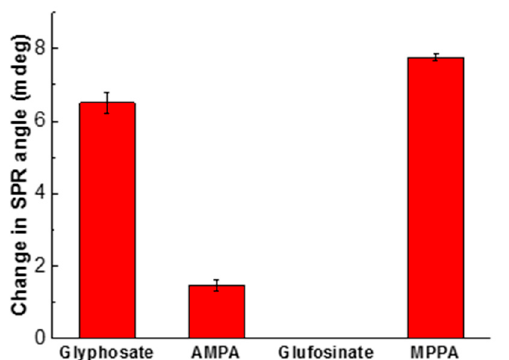
Figure 13. Sorption behavior of glyphosate, AMPA, glufosinate, and MPPA on CS/ZnO SPR sensor at 0.12 μ M and pH 5.5. Experimental conditions: injection of each solution separately into the SPR system with a flow rate of 40 μ L/min at 20.3 °C.